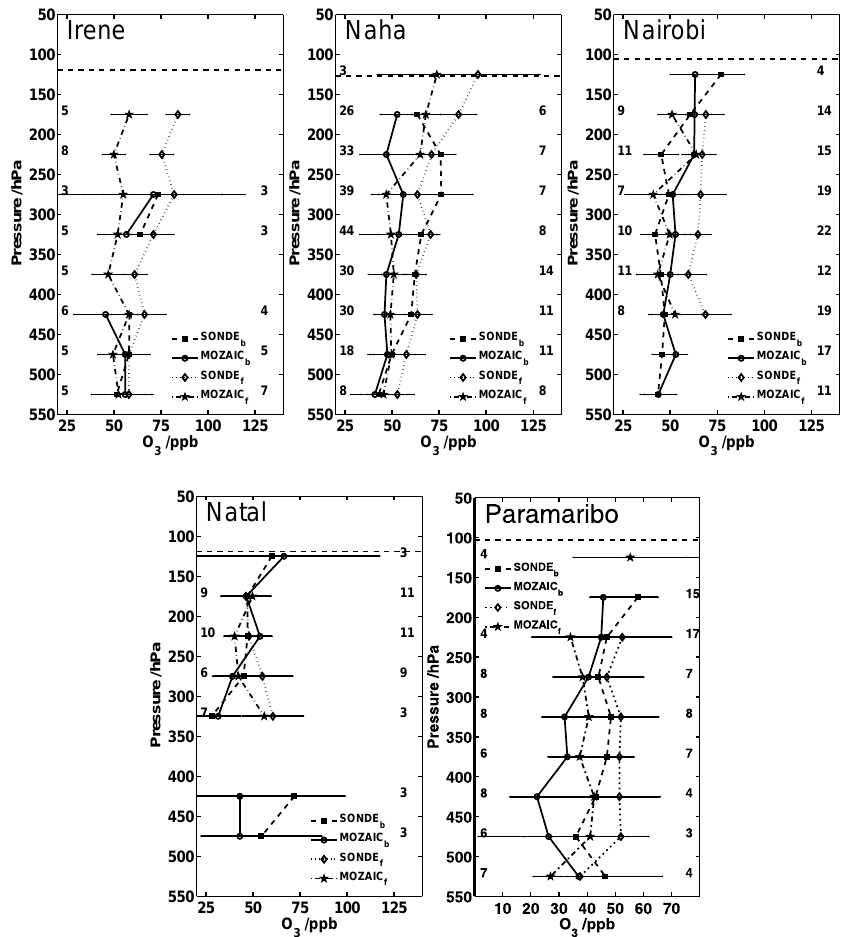
Fig. 15. Comparison of MOZAIC ozone measurements at tropical and southern latitude ozonesonde stations. As for Fig. 12, but for Irene, Naha, Nairobi, Natal, and Paramaribo.